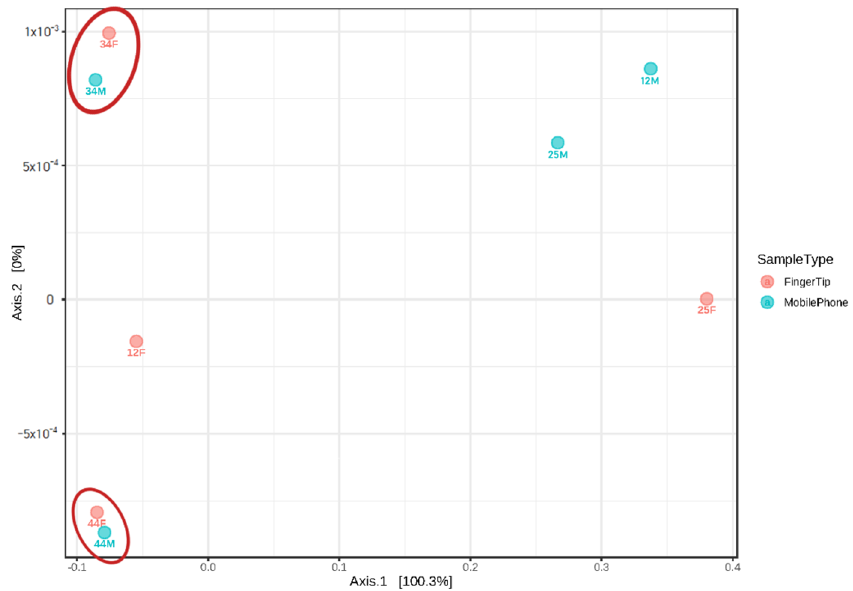
Figure 3. β diversity and relationship of failed STR samples with fingertip-mobile phone (Jensen-Shannon divergence). The correlation is confirmed by measuring the similar distance between each sample using a two-dimensional distance measurement expression. The red circle means nearest sample).